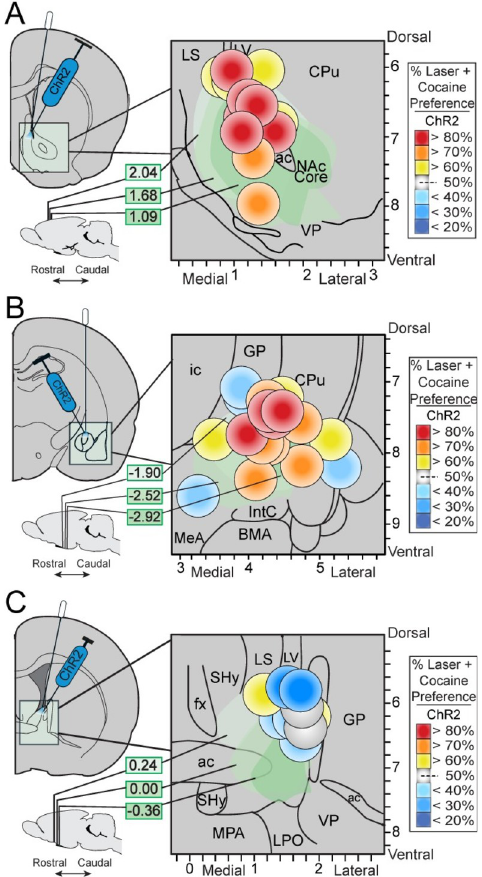
Fig 2. Localization of function maps for Laser+Cocaine preference. Localization of function maps show the magnitude of behavioral effects induced at corresponding histological sites of optic fibers in individual ChR2 CRF rats: A ) nucleus accumbens (NAc) medial shell, B ) central nucleus of the amygdala (CeA), and C ) dorsolateral bed nucleus of the stria terminalis (BNST). Colors indicate intensity (%) of laser-induced pursuit with reds indicating stronger preference for Laser+Cocaine in the two-choice task. Conversely, blue colors indicate avoidance of Laser+Cocaine (or preference for Cocaine alone ). Symbol sizes are scaled to match maximum 0.7mm diameter measured for illuminated ChR2 Fos plumes. Also see S1 Table in S1 File. LS, lateral septum; LV, lateral ventricle; CPu, caudate putamen; NAc, nucleus accumbens; VP, ventral pallidum; ac, anterior commissure; ic, internal capsule; MeA, medial amygdala; GP, globus pallidus; IntC, intercalated amygdala; BMA, basomedial amygdala; BLA, basolateral amygdala; fx, fornix; Shy, septohypothalamic nucleus, MPA, medial preoptic area; LPO, lateral preoptic area.